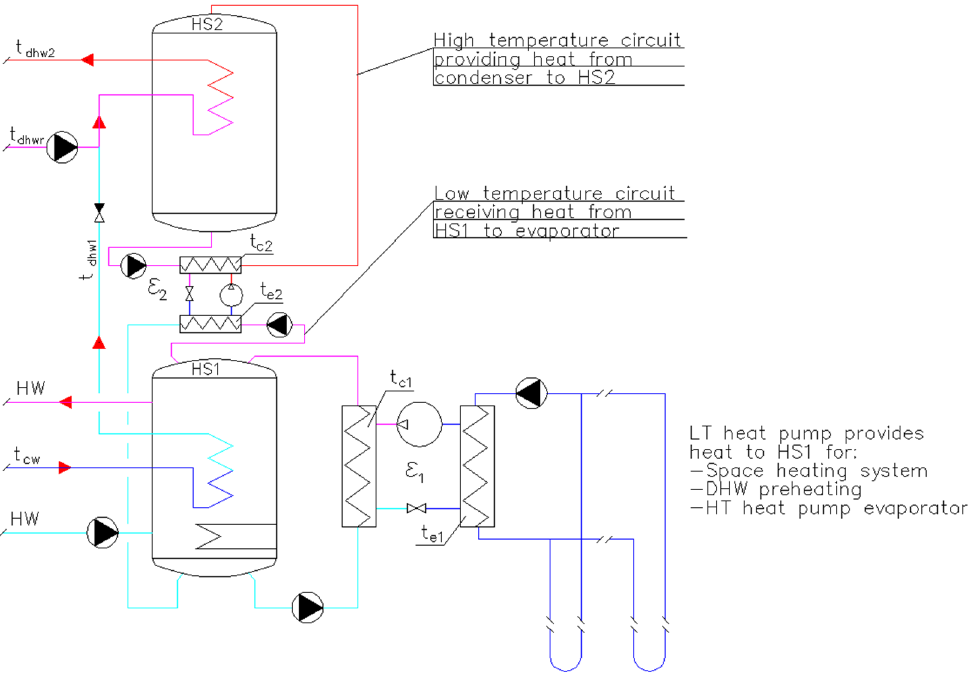
Figure 4. DHW production System 7, the two-stage heat